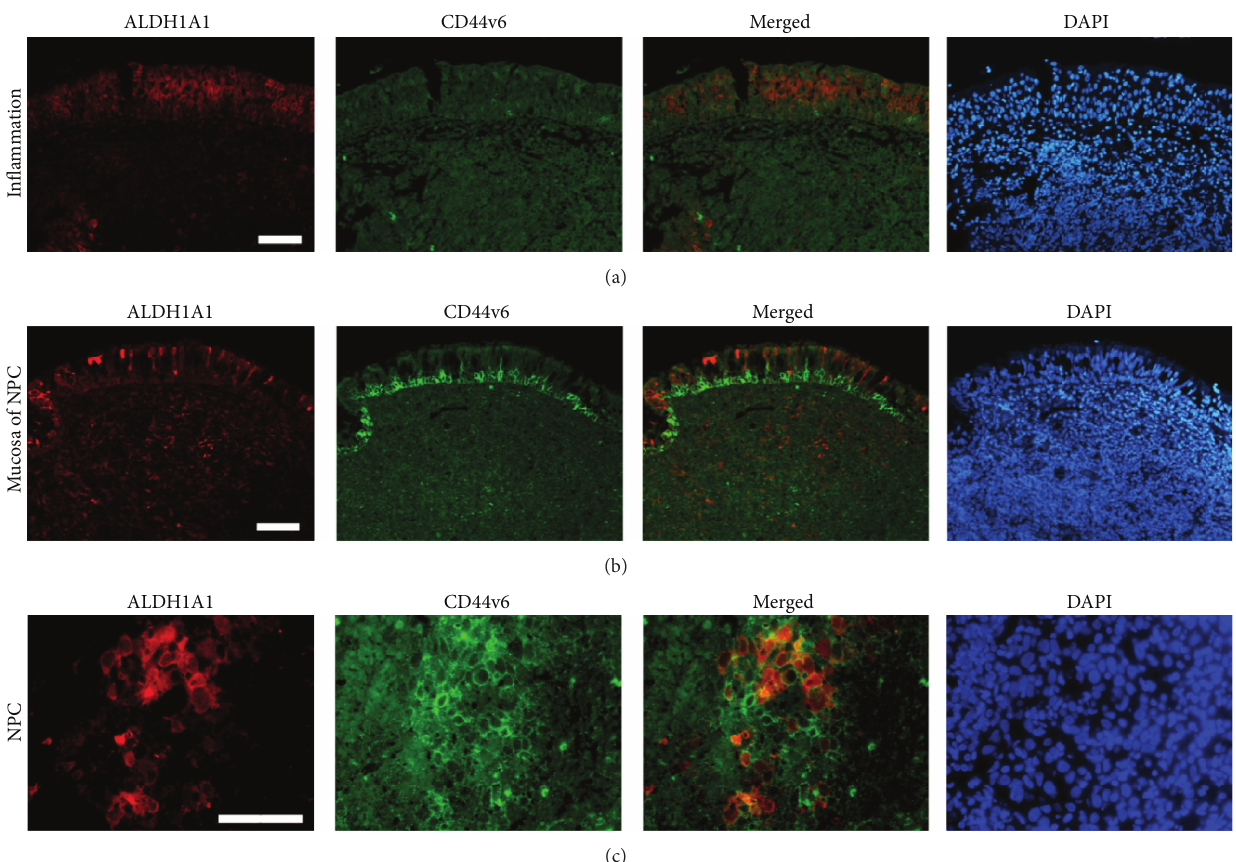
Figure 3: Double immunofluorescence staining of ALDH1A1 and CD44v6 in chronic nasopharyngitis and NPC tissues. The expression of CD44v6 (green) and ALDH1A1 (red) was assessed by immunofluorescence staining. Nuclei were counterstained by DAPI (blue). Original magnification is 100x (a, b) and 200x (c). Scale bar represents 50 𝜇